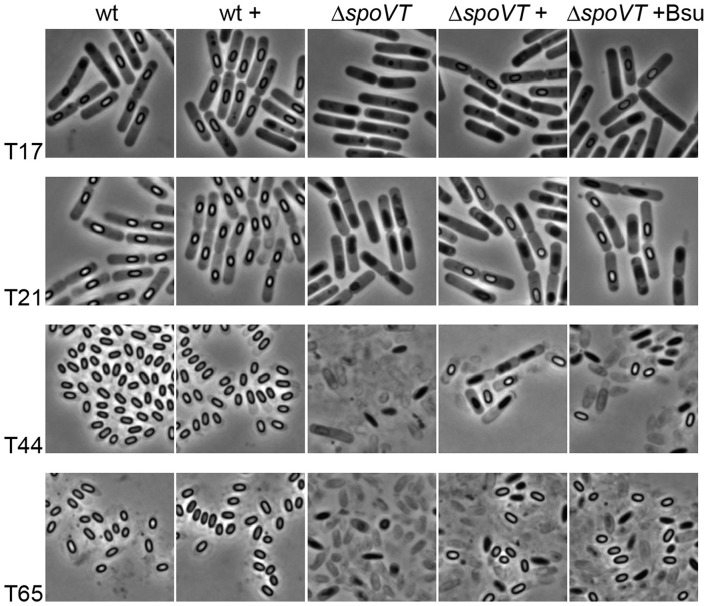
Sporulation of B. cereus in the presence and absence of SpoVT. Sporulation was induced by growth in MSM medium and the progress of sporulation was monitored using phase-contrast microscopy for the B. cereus ATCC 14579 wild type strain (wt) and spoVT deletion strain (ΔspoVT) with plasmid-borne spoVTBCE (+) or spoVTBSU(+Bsu) (originating from the pNWVT or pVTBsu2 vector, respectively). The B. cereus wt strain with extra plasmid-borne spoVTBCE (wt +) was added as a control to ensure no unexpected sporulation defects were occurring due to pNWVT-derived spoVT expression during sporulation. Samples were analyzed after 17, 21, 44, and 65 h of growth after initial dilution in fresh medium.